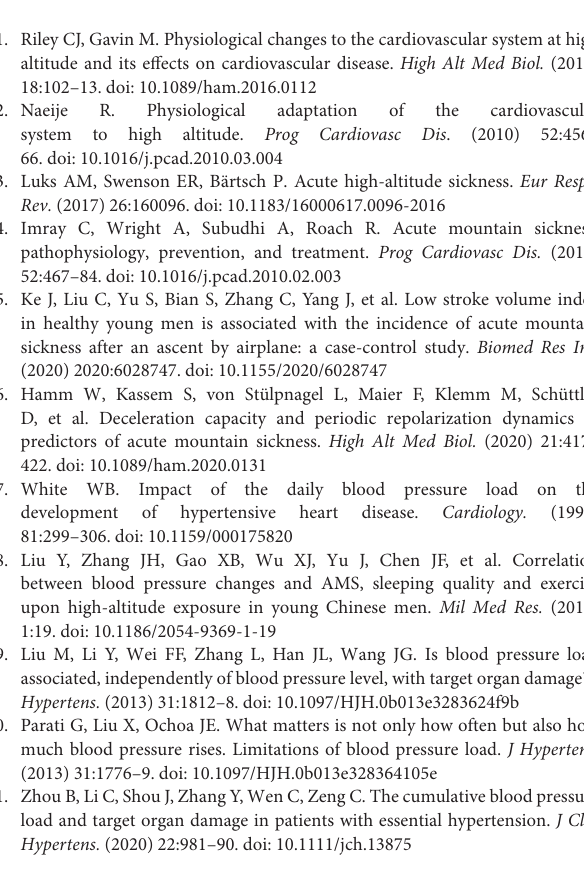
Supplementary Figure 1 | Correlation between delta 24-h DBP parameters and AMS score. (A) Correlation between delta 24-h DBP after HA exposure and AMS score in all subjects. (B) Correlation between delta 24-h ARVd after HA exposure and AMS score in all subjects. (C) Correlation between delta 24-h DBP load after HA exposure and AMS score in all subjects. (D) Correlation between delta mean 24-h cDBPL after HA exposure and AMS score in all subjects. HA, high